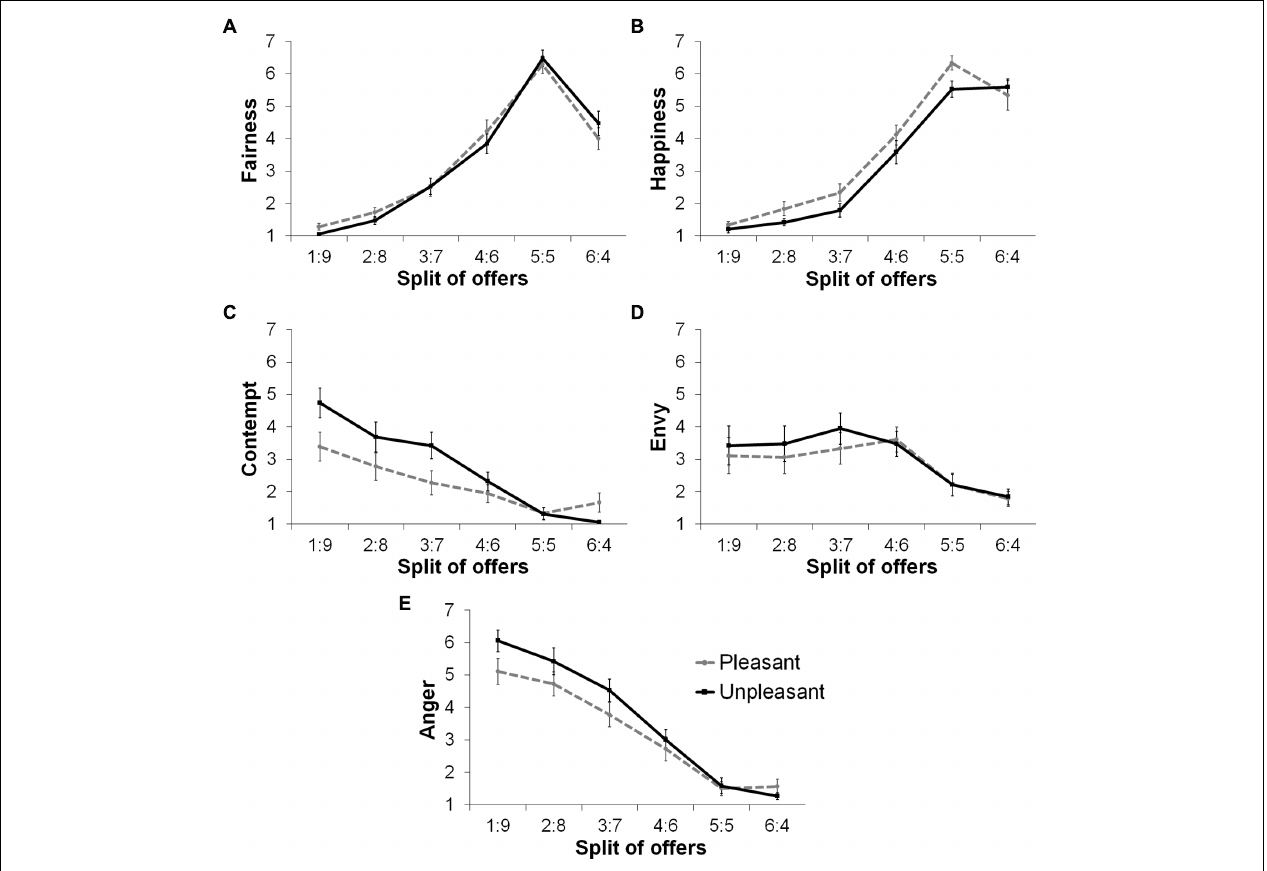
FIGURE 5 | Self-reported fairness and felt emotional reactions to each split of offer by group. Fairness (A) , Happiness (B) , Contempt (C) , Envy (D) , and Anger (E) .